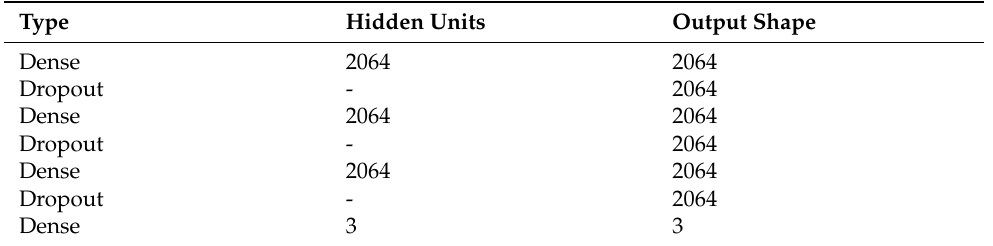
Table 3. NN regression model with input size